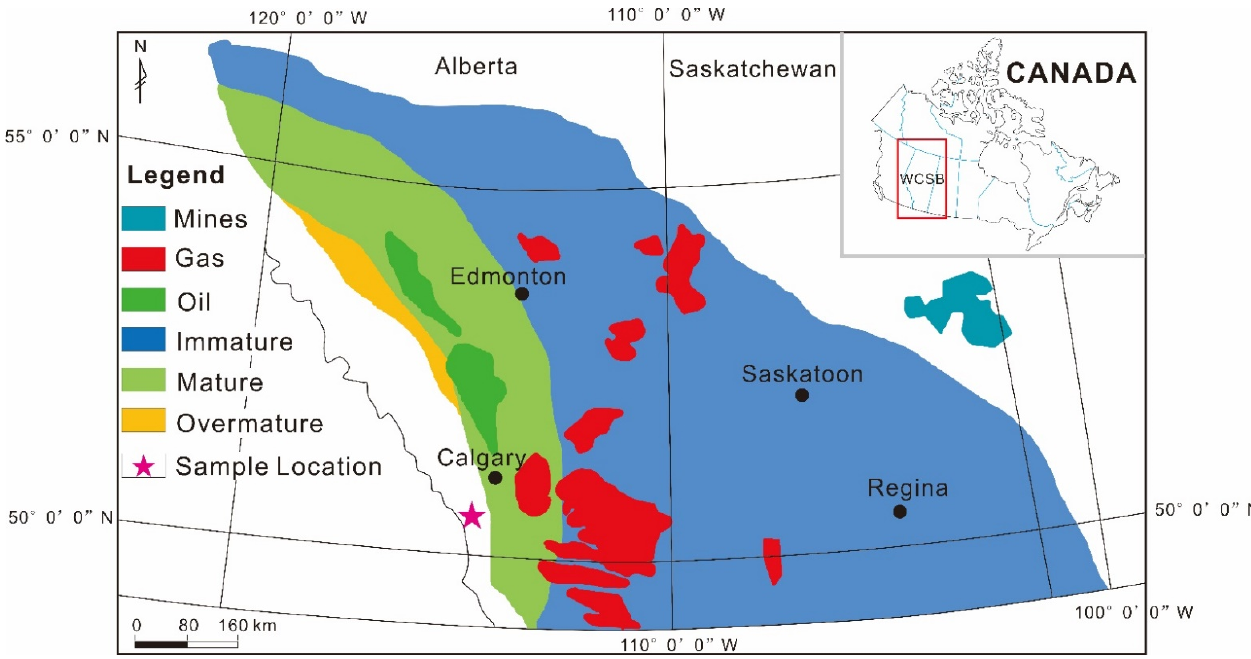
Figure 1. Thermal maturity of the 2WS and its related petroleum distribution in the Western Canada Sedimentary Basin (adapted with permission from Huang et al., 2022 [38]).